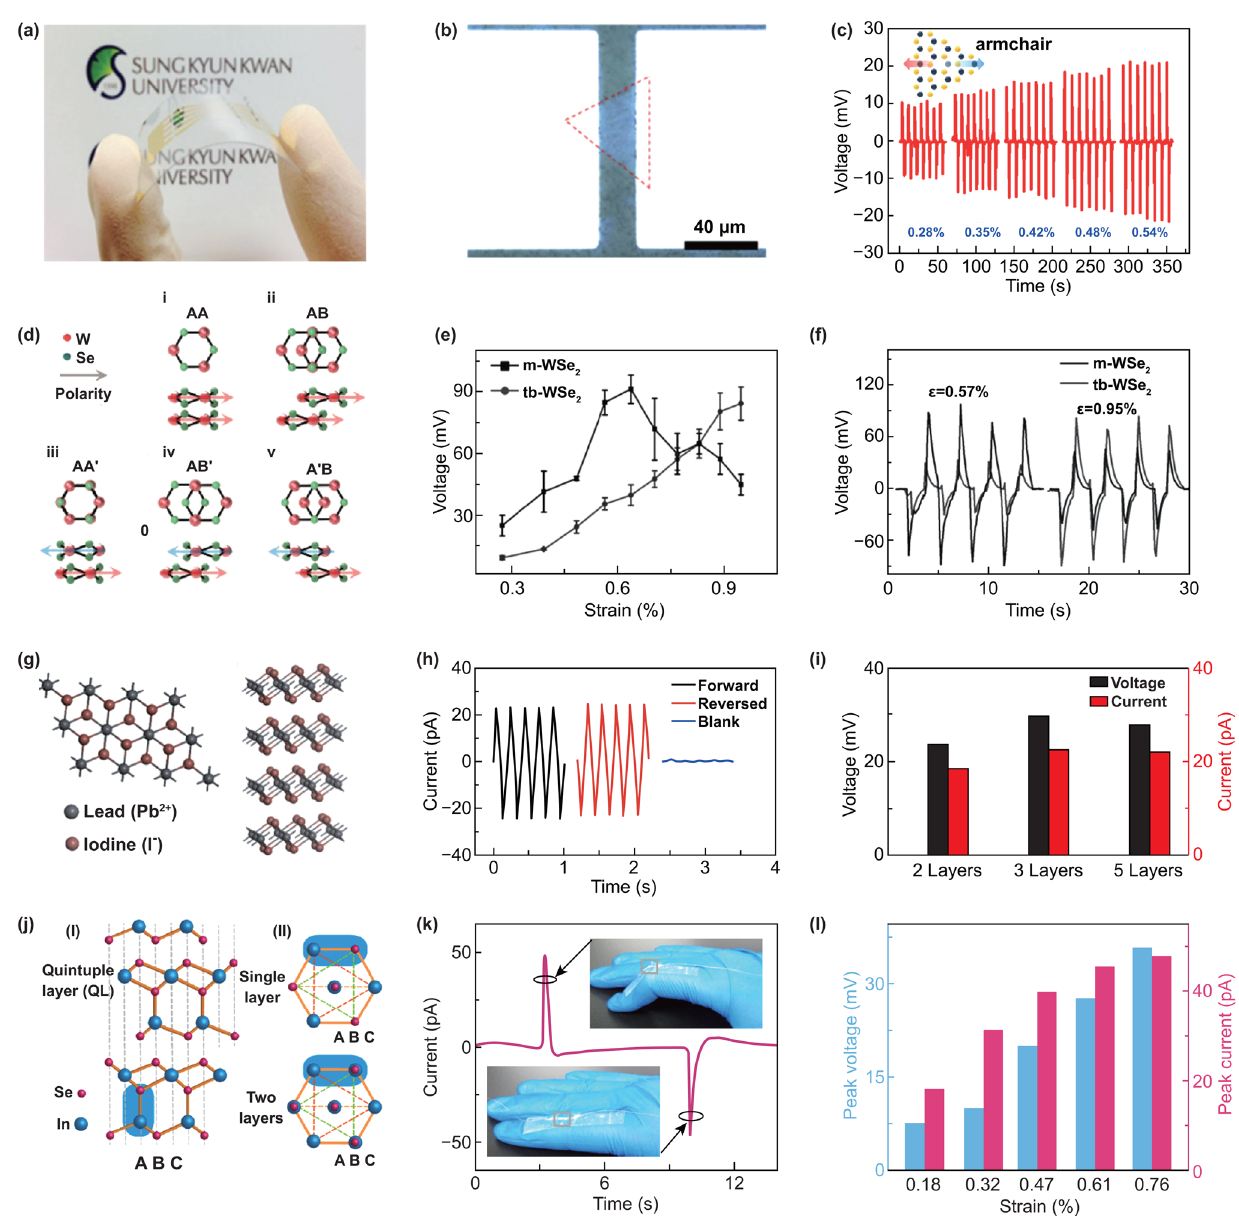
Fig. 18 Piezoelectric generators based on 2D semiconductors a Photographic image of the CVD-grown monolayer MoS 2 -based flexible piezo- electric NG. b Optical images showing energy harvesting active regions with the armchair atomic orientations of the piezoelectric NG. c Output voltage obtained from the monolayer MoS 2 NG under different applied strain. Reproduced with permission [176]. Copyright 2016, Elsevier. d Stacking structure for bilayer-WSe 2 . e Piezoelectric peak output voltages of monolayer WSe 2 and bilayer WSe 2 as a function of strain. f Piezo- electric output voltage of m-WSe 2 (black line) and tb-WSe 2 with a low strain. Reproduced with permission [217]. Copyright 2017, Wiley–VCH. g Crystal structure of monolayer and multilayer PbI 2 . h Piezoelectric output current of 2D PbI 2 device. i Piezoelectric peak output voltages of devices fabricated with 2, 3, and 5 layers PbI 2 nanosheets. Reproduced with permission [218]. Copyright 2018, American Chemical Society. j Atom structure of hexagonal α-In 2 Se 3 . k An α-In 2 Se 3 piezoelectric nanogenerator is integrated on an index finger to scavenge the mechanical energy induced by finger motions. l Strain dependence of the piezoelectric voltage output. Reproduced with permission [218]. Copyright